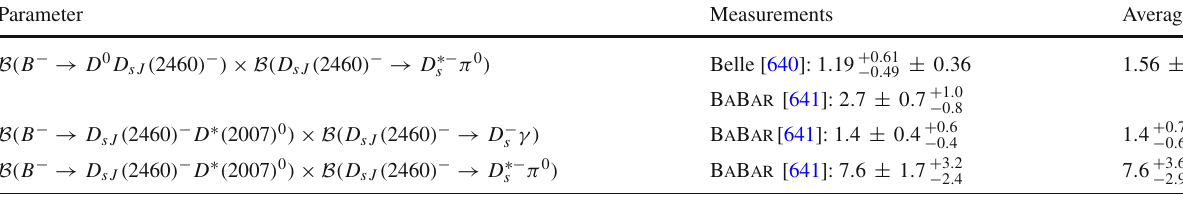
Table 157 Product decays rates to excited D s mesons I [ 10 − 3 ] Parameter